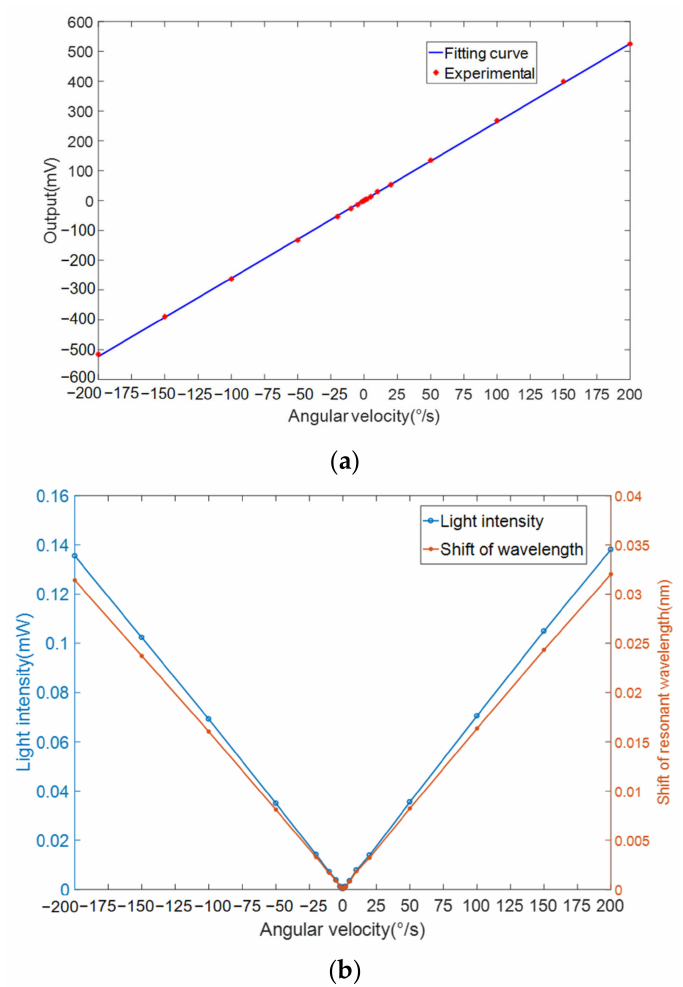
Figure 24. The relationship between output and angular velocity. ( a ) Voltage. ( b ) Light intensity and the shift of resonant wavelength.